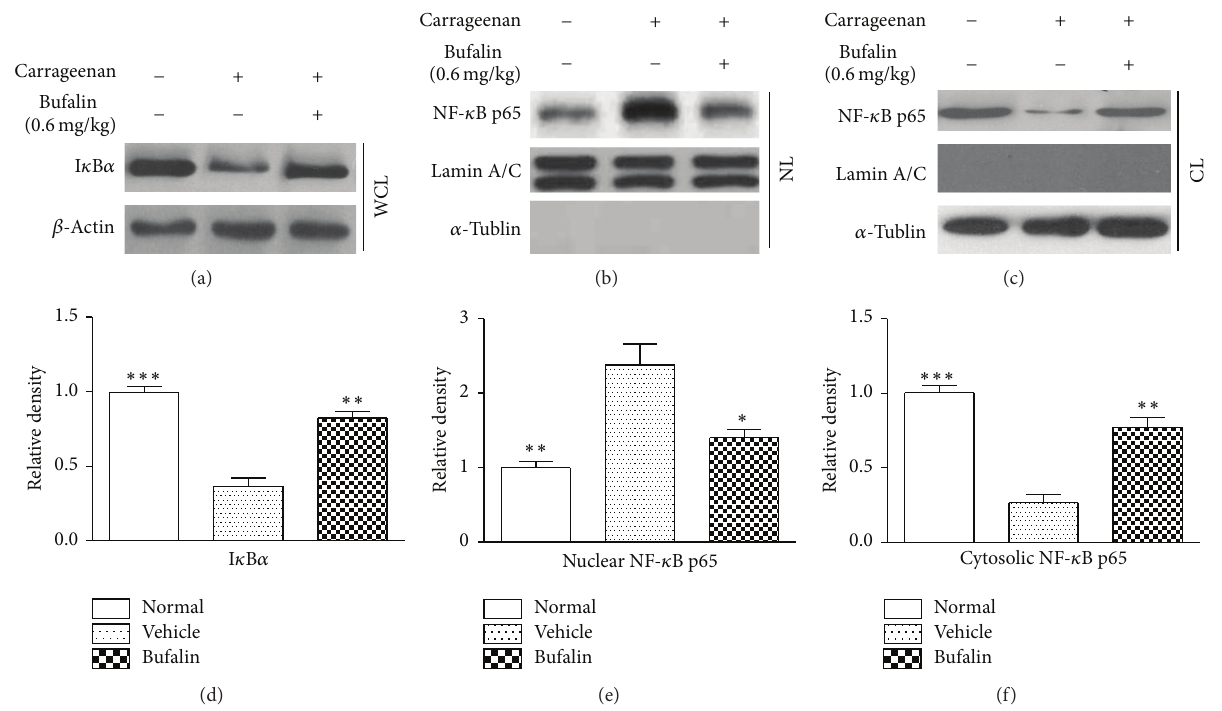
Figure 3: Bufalin interfered with activation of NF- 𝜅 B signaling in the carrageenan-induced paw edema model. In this experiment, the dose of bufalin was 0.6 mg/kg. (a) The level of I 𝜅 B 𝛼 was detected by western blot. The nuclear (b) and cytosolic (c) NF- 𝜅 B p65 were monitored after 0.6 mg/kg bufalin injection by western blot. The levels of I 𝜅 B 𝛼 (d), nuclear (e), and cytosolic (f) p65 were analyzed using Image J.2x software. Data are expressed as the mean ± S.E.M. of 3 determinations, ∗ P < 0.05, ∗∗ P < 0.01, and ∗∗∗ P < 0.001, compared with the vehicle group. WCL: whole cell lysate, NL: nuclear lysate, and CL: cytosolic